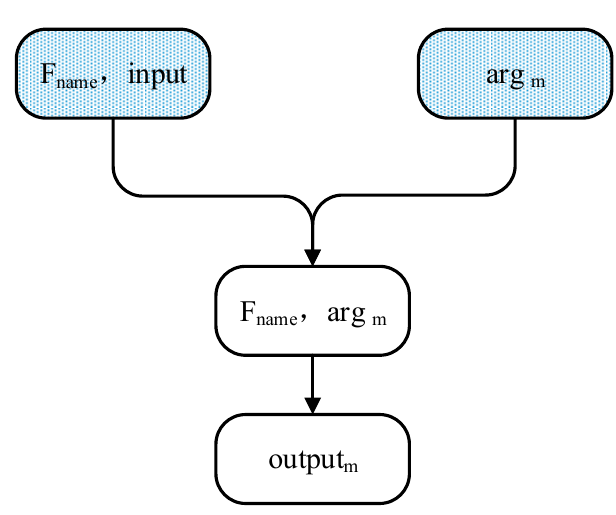
Figure 16. Constructed module.